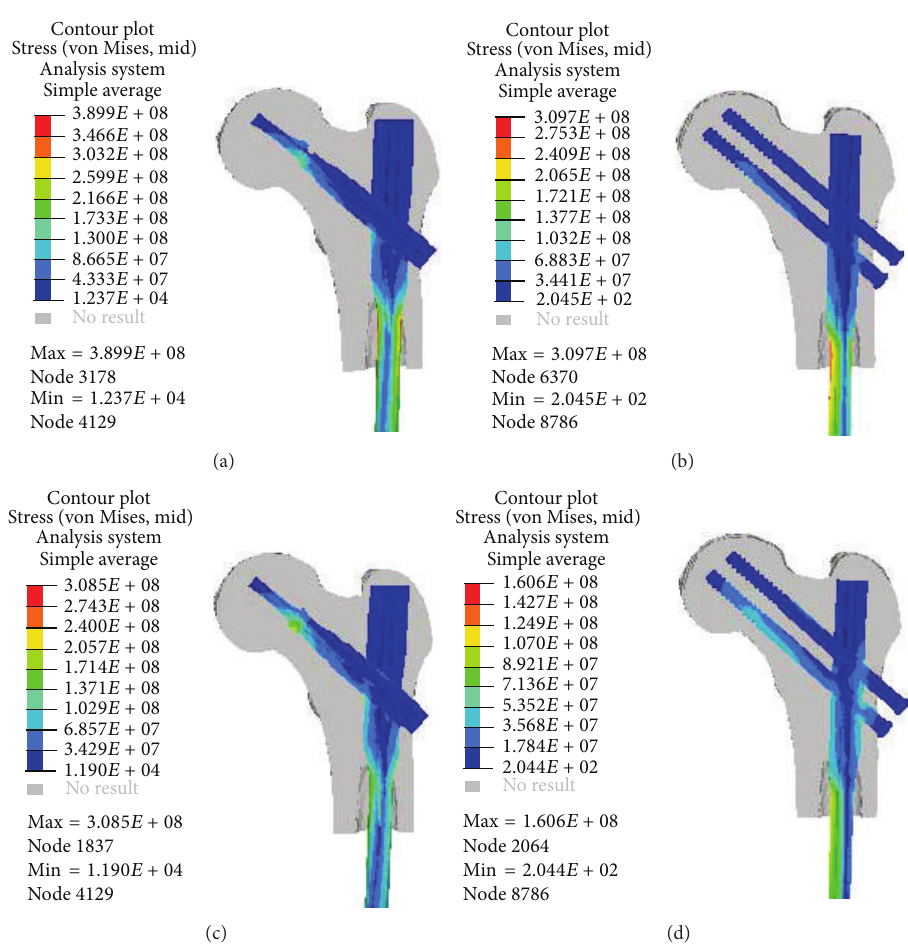
Figure 2: Comparison of von Mises stresses of the PFNA-II and A2FN implants in the two different healing stages from section view (a, b) in the soft callus stage, (c, d) in the hard callus